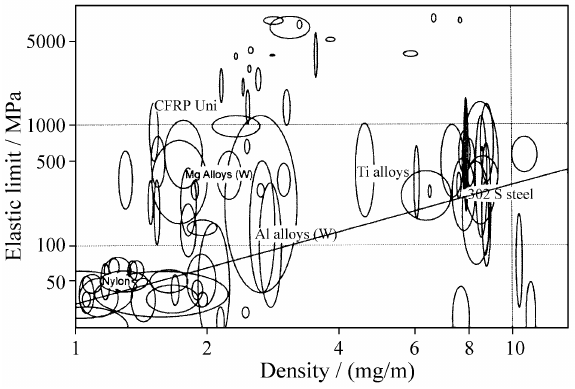
Figure 5. Material property map ( σ vs. ρ ) for the centrifuge rotor material Table 2. Initial requirements.